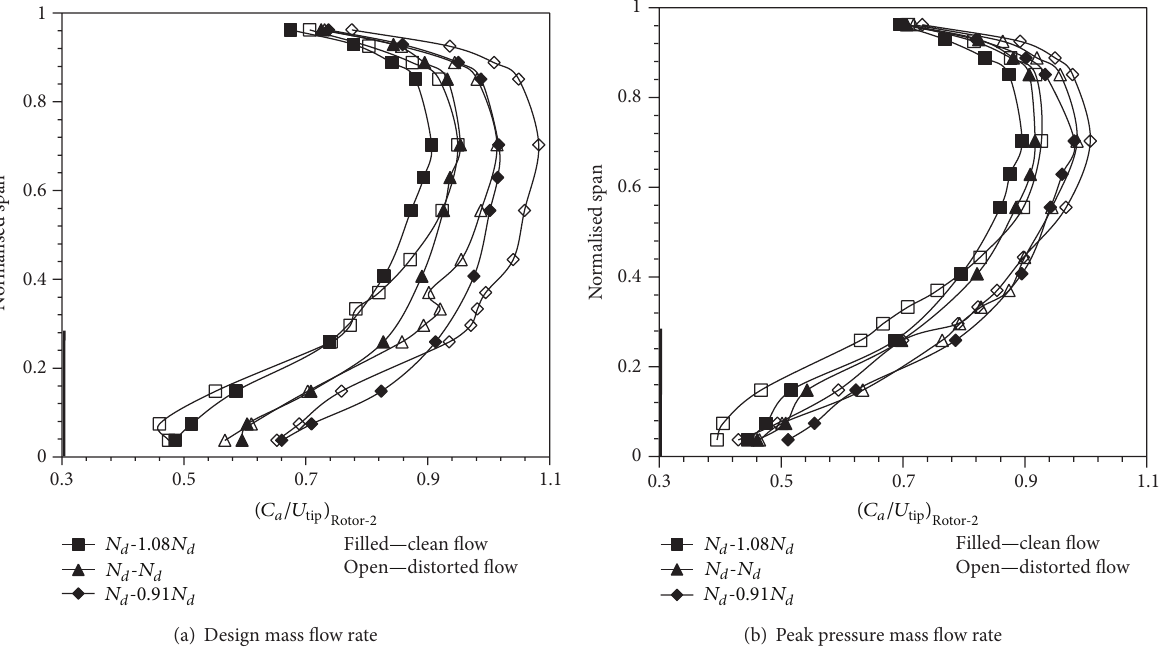
Figure 7: Spanwise variation of axial velocity ratio at the exit of